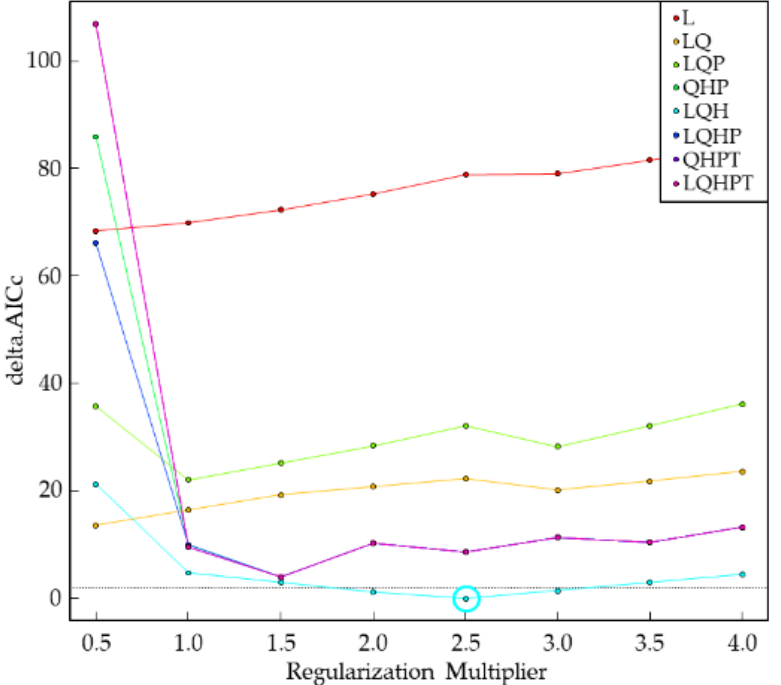
Figure 1. The regularization multiplier and feature classes of S. nitobei in the maximum entropy model.